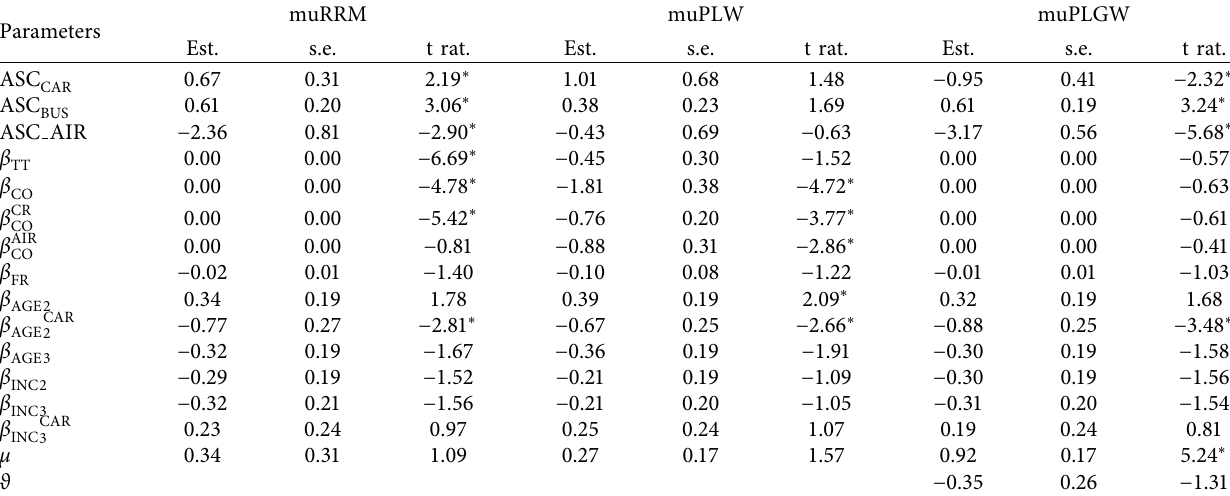
Table 7: Estimates of the μ RRM, μ PLW, and μ PLGW for business purpose of the CR experiment.